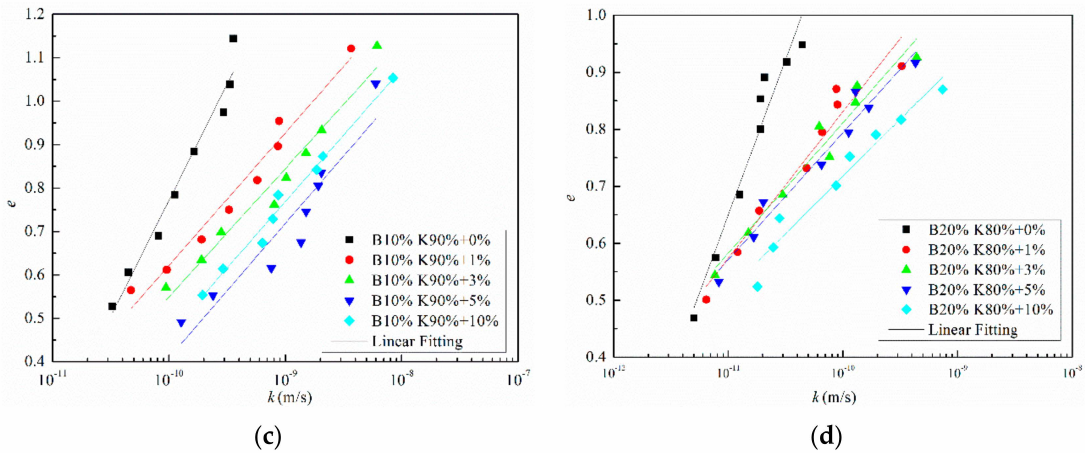
Figure 6. The relationships between log k and void ratio e for samples with di ff erent salinities: ( a ) K;